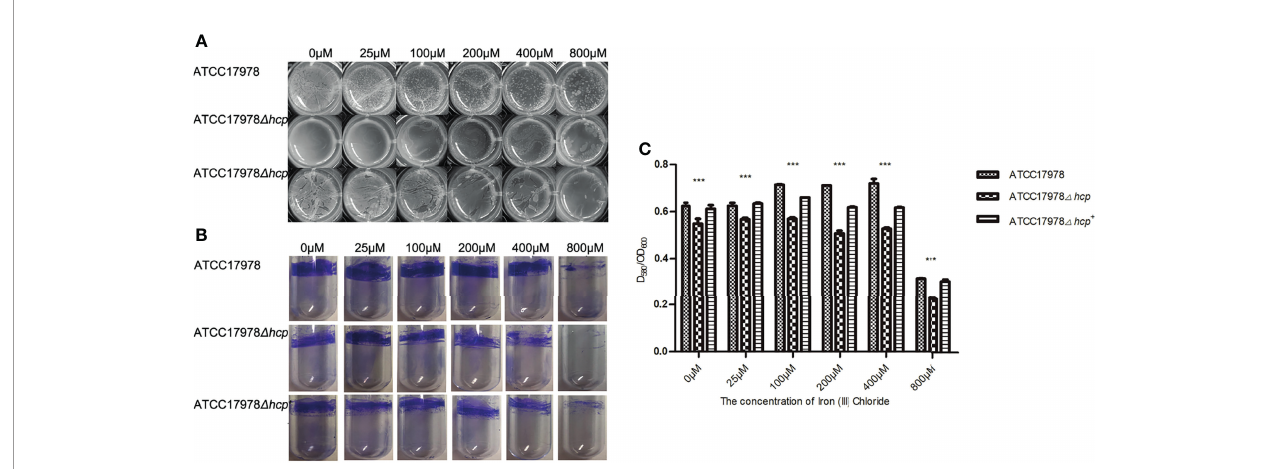
FIGURE 1 | Roles of hcp gene and iron ions in ATCC17978, ATCC17978 D hcp , and ATCC17978 D hcp + bio fi lm formation. (A) Bio fi lm formation in 24-well cell culture plates. (B) Crystal violet staining of bio fi lm formation rings in 5-ml polystyrene tubes. (C) Ratio of optical density (OD) of bio fi lm formation measured by crystal violet staining and growth turbidity (OD 580 /OD 600 ) (the asterisks indicate a signi fi cant difference in bio fi lm formation ability between ATCC17978 and ATCC17978 D hcp strains at the same iron ion concentration). *** p < 0.0001.